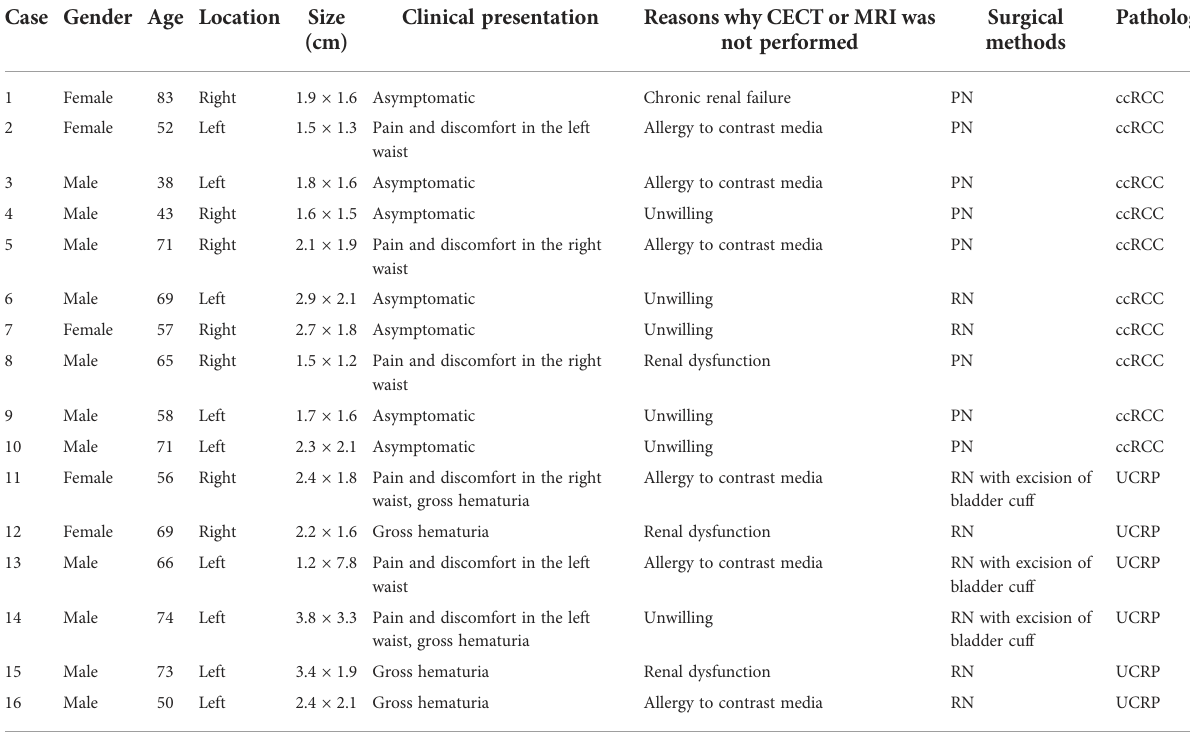
TABLE 1 Clinical characteristics of the 16 patients with renal